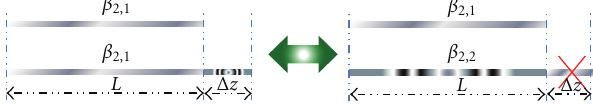
Figure 3: Length-dispersion